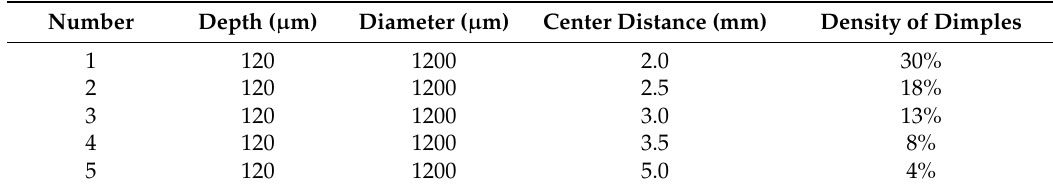
Table 3. Geometric parameters of the biomimetic samples.